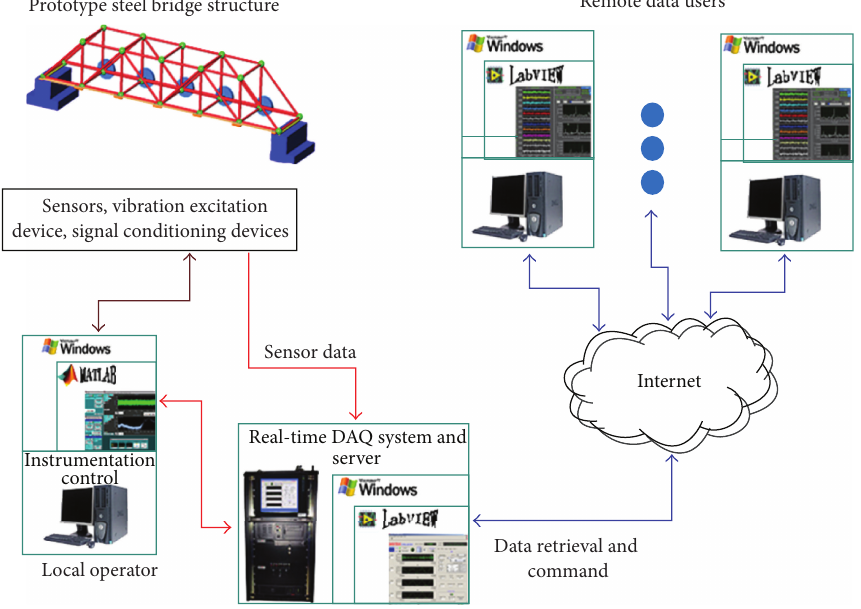
Figure 3: Configuration of the hardware system for experimental